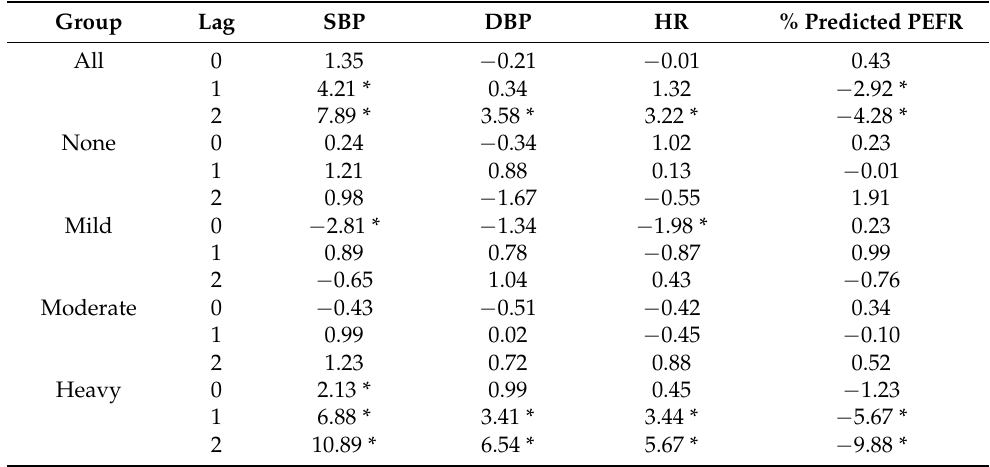
Table 3. Changes in health measurements resulting from an interquartile range change in lag0 to lag2 of total volatile organic compound levels in mixed-effects models.